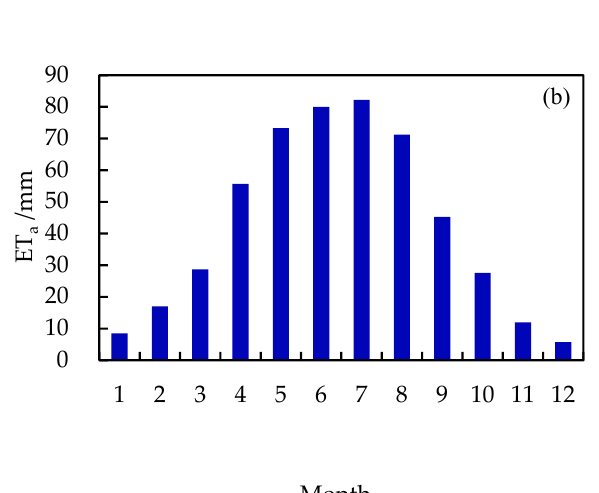
Figure 2. The variation of the annual, seasonal and monthly ET a in the Weihe River Basin from 1970 to 2018. ( a ): Annual and seasonal; ( b ):